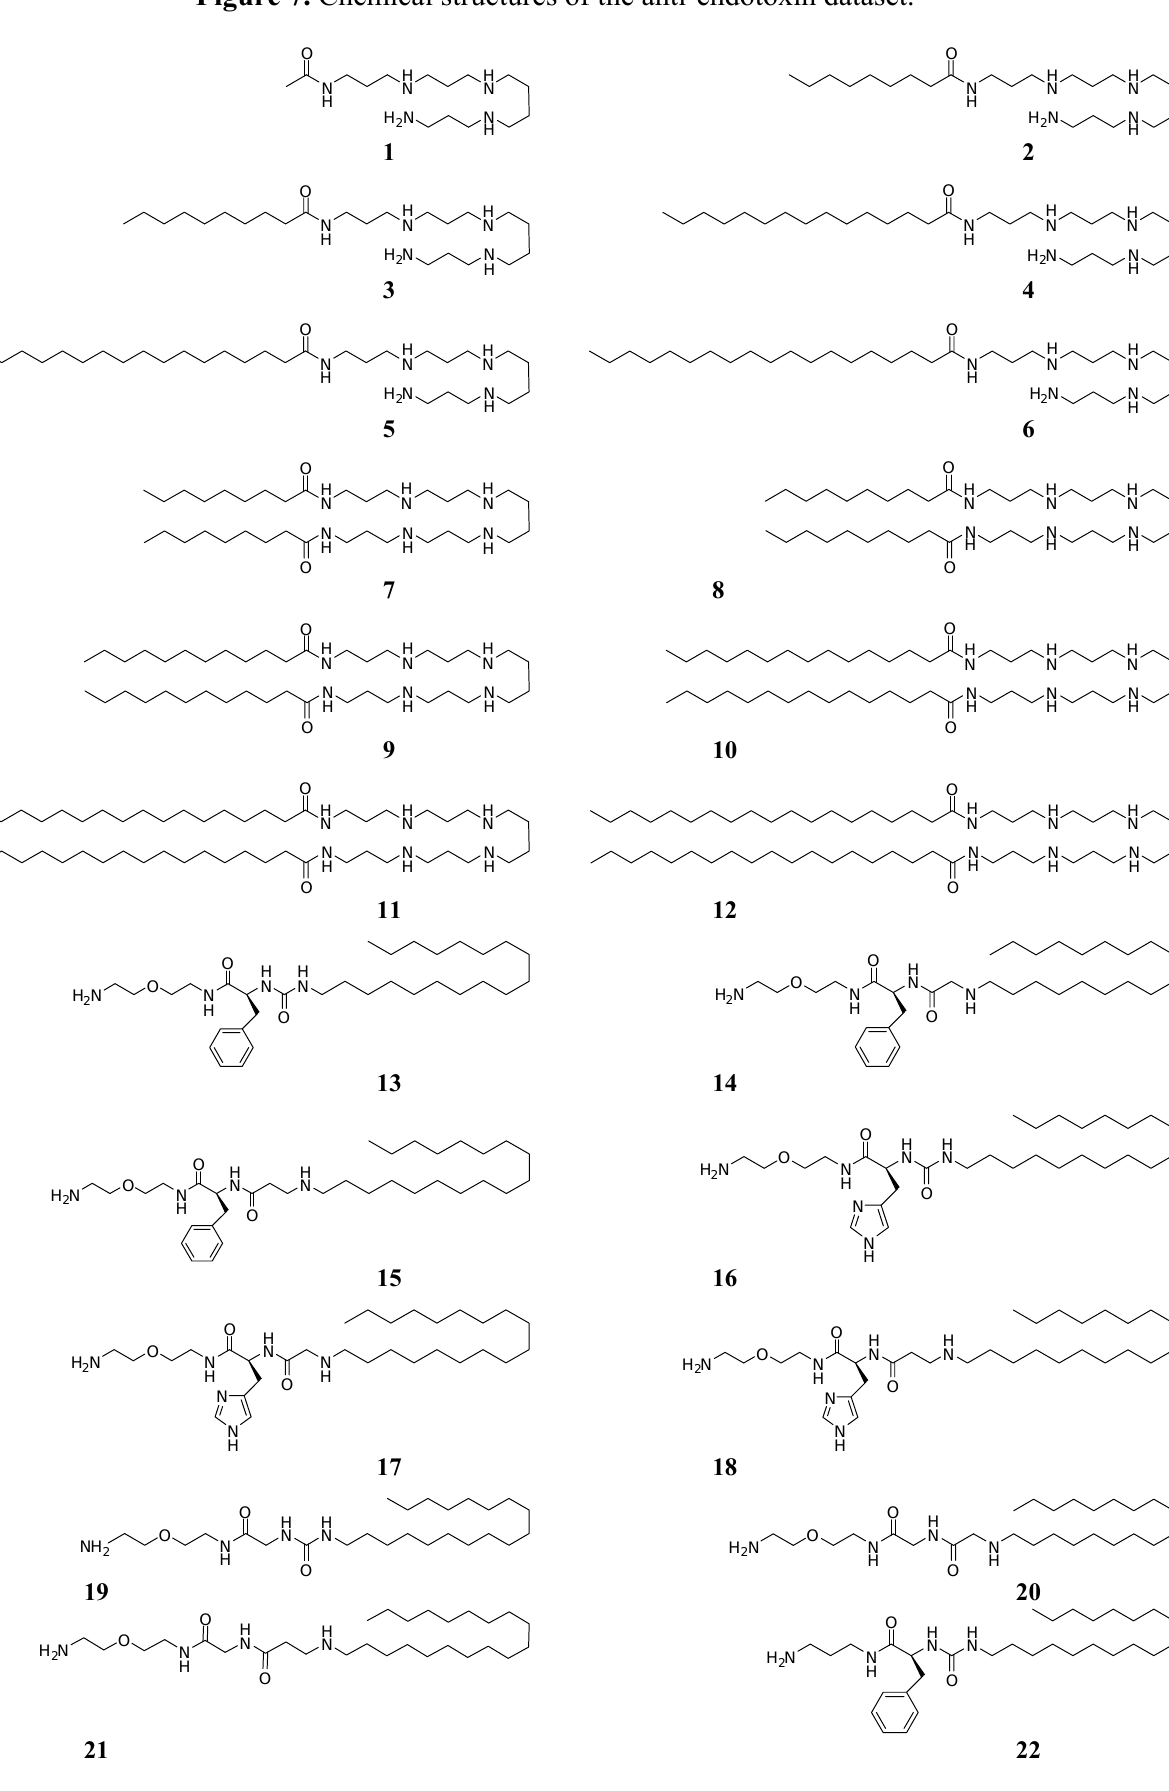
Figure 7. Chemical structures of the anti-endotoxin